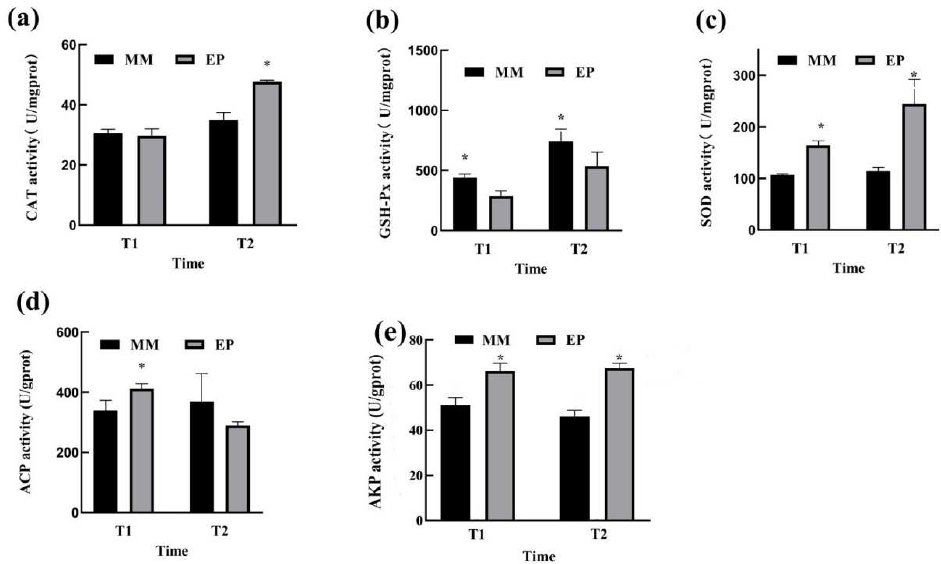
Figure 3. Differences in ( a ) CAT, ( b ) GSH-Px, ( c ) SOD, ( d ) ACP, and ( e ) AKP activities in largemouth bass at different time points. Data are means ± SD. * indicates statistically significant differences between the MM and EP groups at each time point ( p < 0.05).